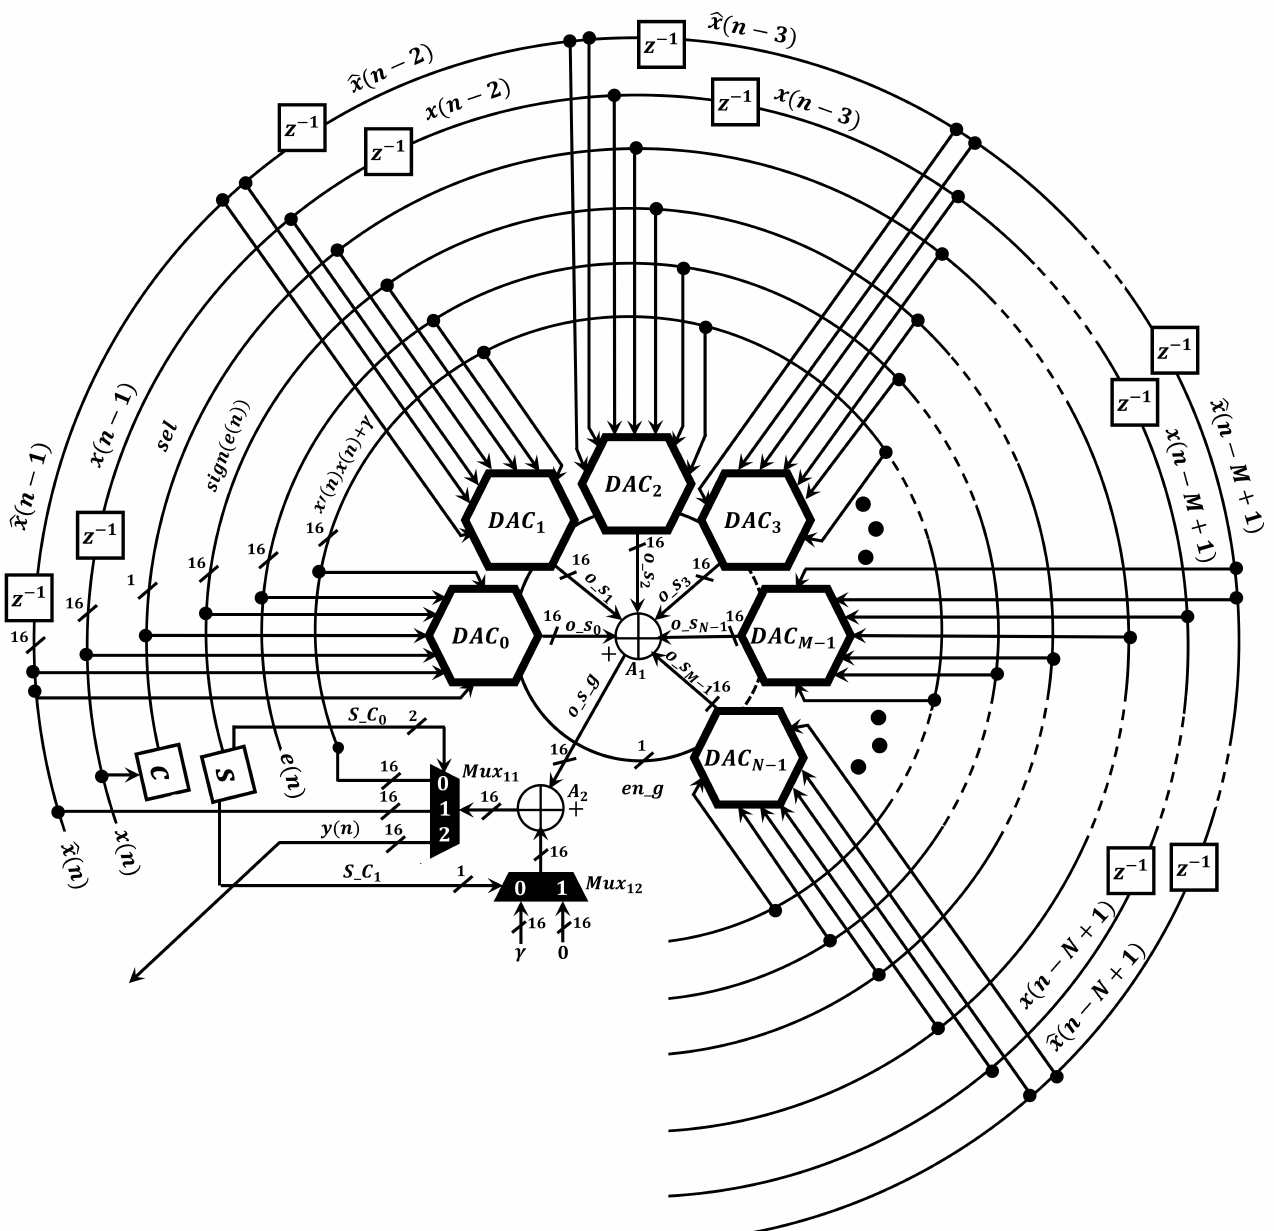
Figure 4. General scheme of the proposed spike-based hardware